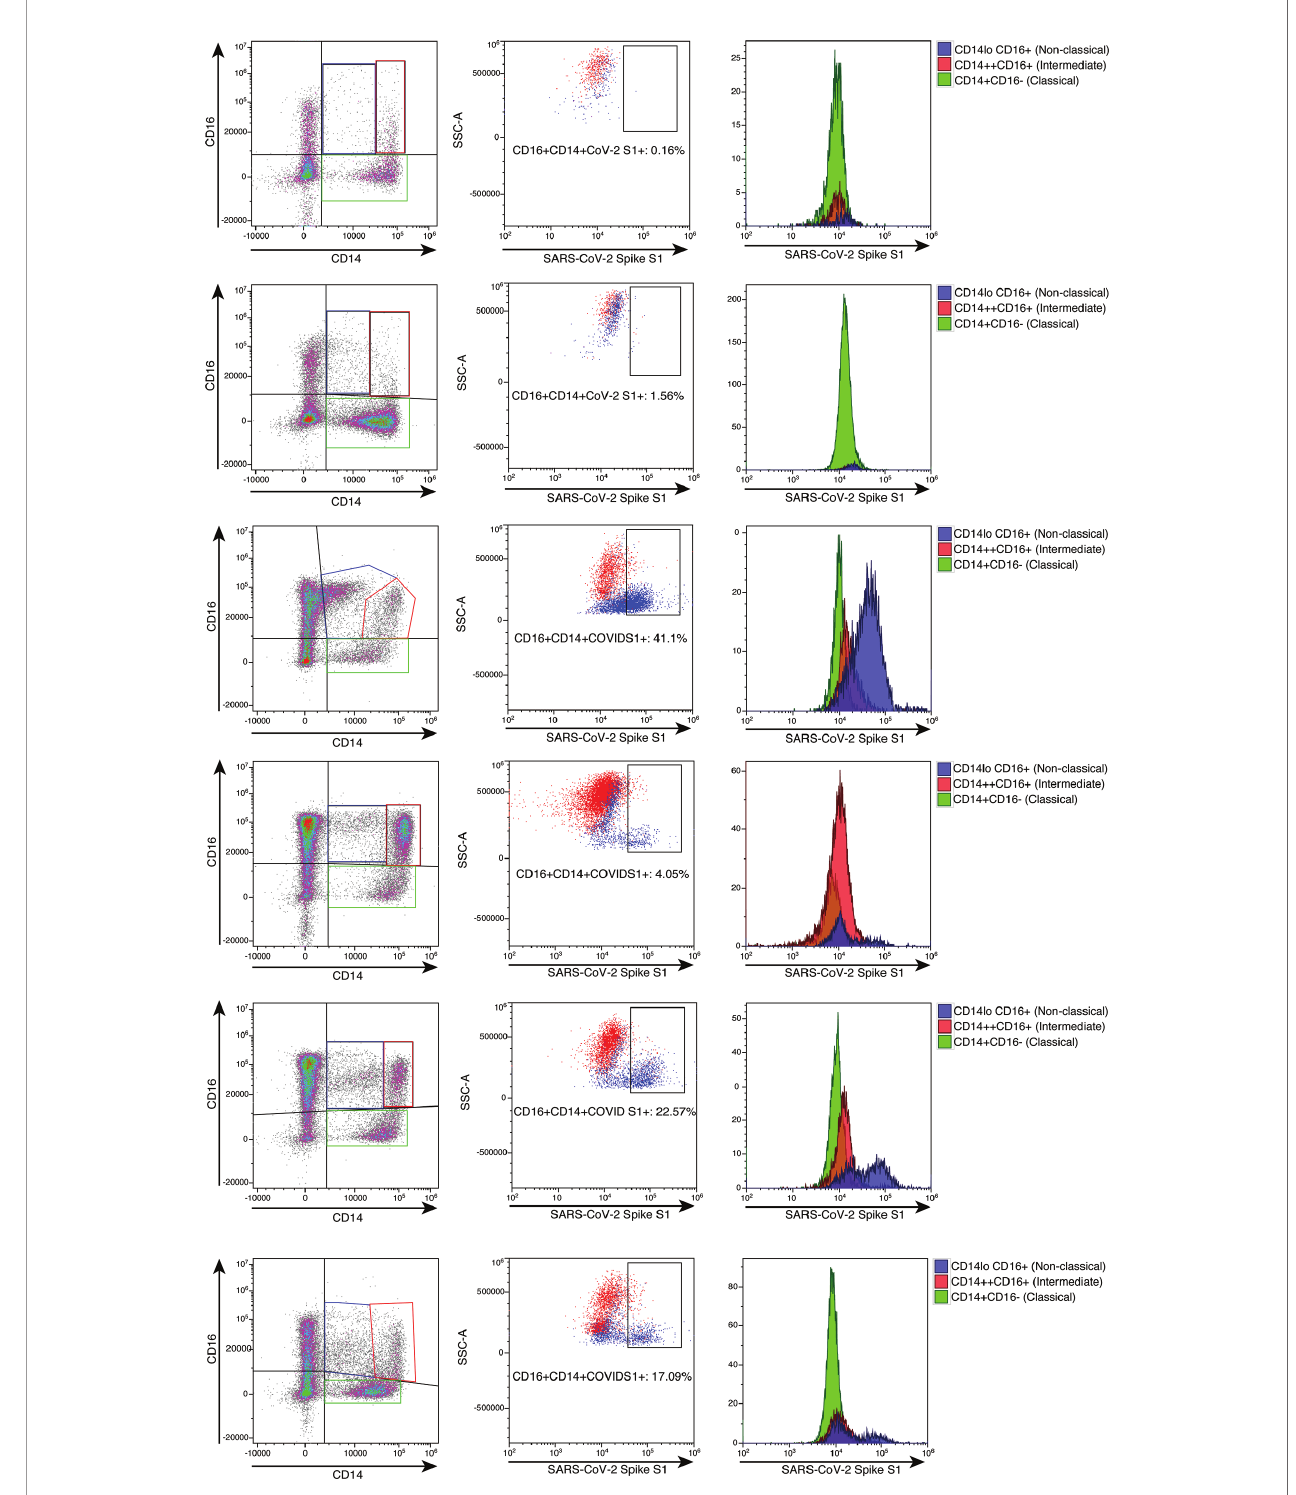
FIGURE 2 | High parameter fl ow cytometric quanti fi cation of SARS-CoV-2 S1 protein in monocytic subsets. Cells were gated as demonstrated in Supplementary Figure 1 . Each horizontal row represents an individual patient. A representative healthy control is demonstrated in the top row. All subsequent rows represent the spectrum of S1 containing monocytes. Classical monocytes are green, intermediate monocytes are red and non-classical monocytes are